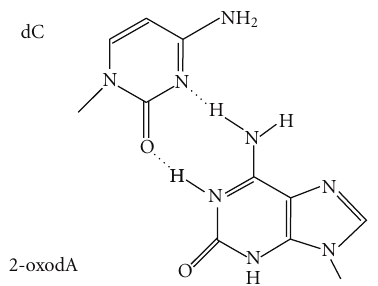
Figure 4: Possible wobble structure for base pairing of the 1,2- dihydro-2-oxoadenine